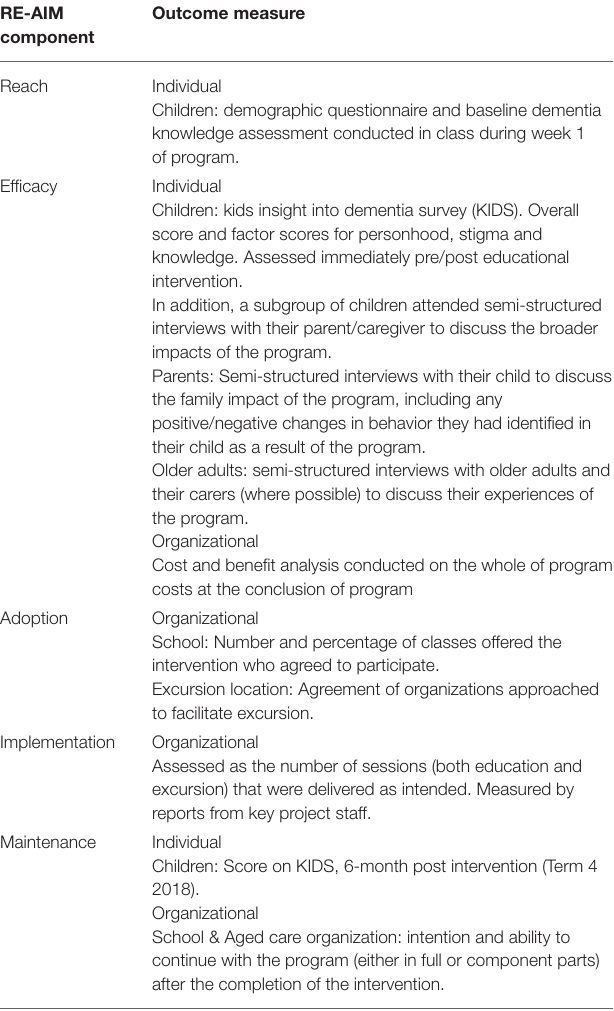
TABLE 2 | RE-AIM components and associated outcome measures for the program. RE-AIM Outcome measure component